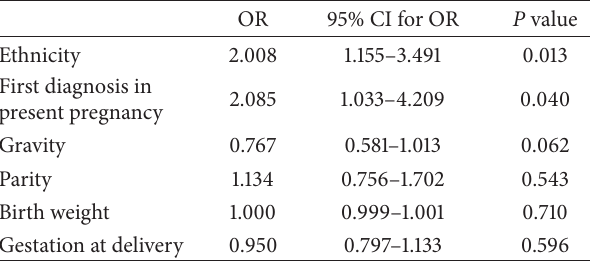
Table 3: Results of multivariate analysis on factors for a woman to have an early anomaly